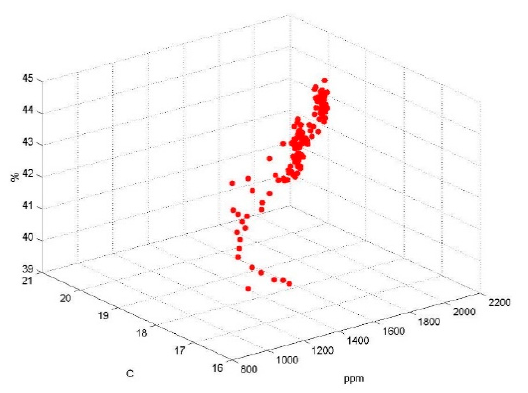
Figure 1. Correlation of carbon dioxide concentration, air temperature and relative humidity in the analyzed conference